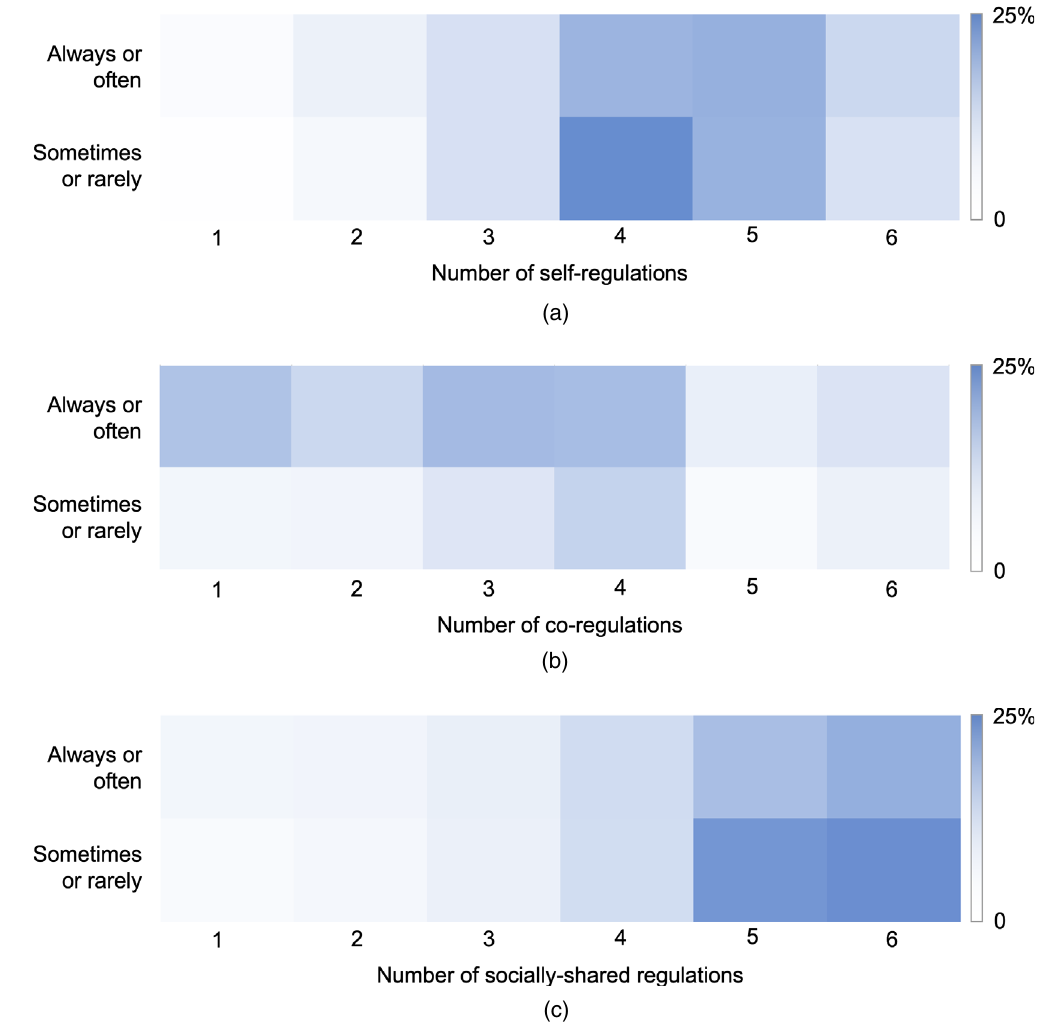
FIG. 9. Students were asked to rank the frequency with which they used each of the 18 regulations to overcome their “ largest challenge. ” We separate these regulations into subcategories of (a) self-regulations, (b) co-regulations, (c) socially shared regulations. Here, we plot the percentage of respondents who reported using each particular number of regulations for each particular frequency. For example, about 25% of respondents reported that they used four of the self-regulations, but used them only “ sometimes or rarely ” with n ¼ 369 ). The color of the block gives the percent of respondents who fall into each particular